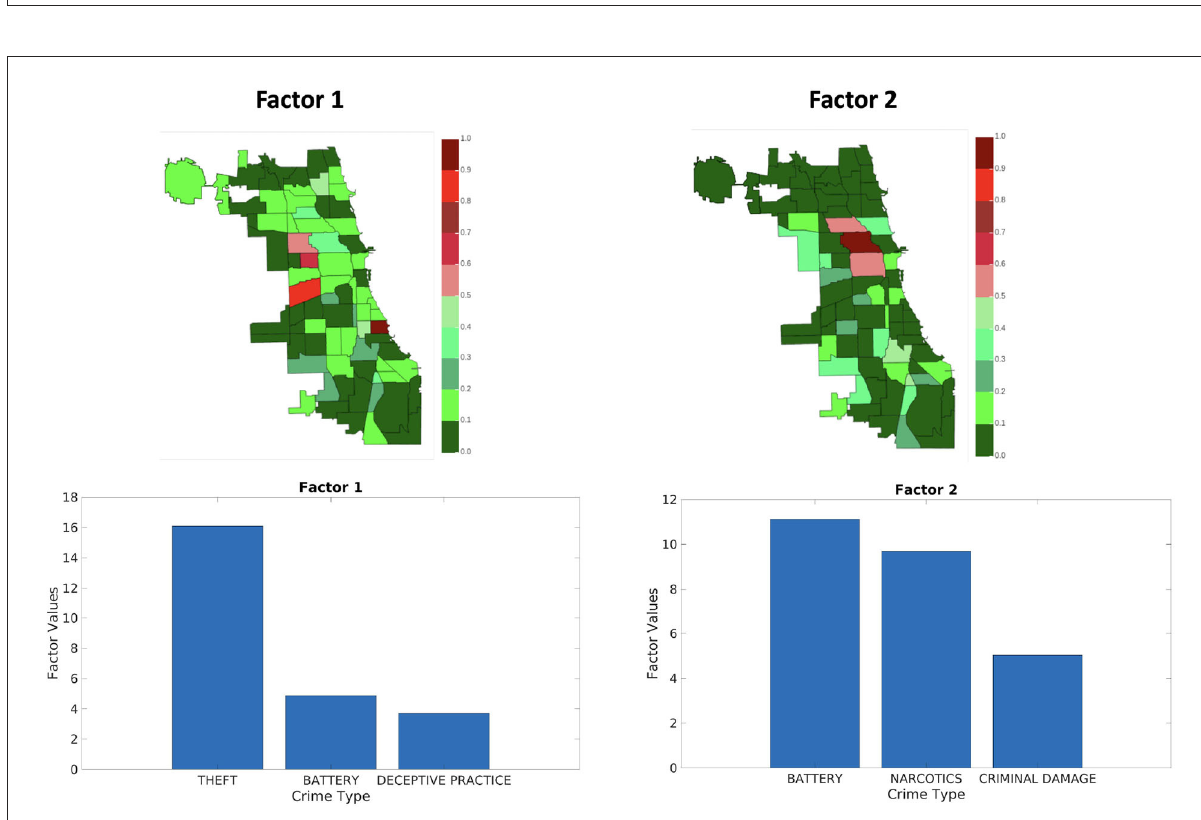
FIGURE10 Analyzing the Chicago data from iteration-3 (X 2 ). Chicago heatmap value ranges from 0.0 to